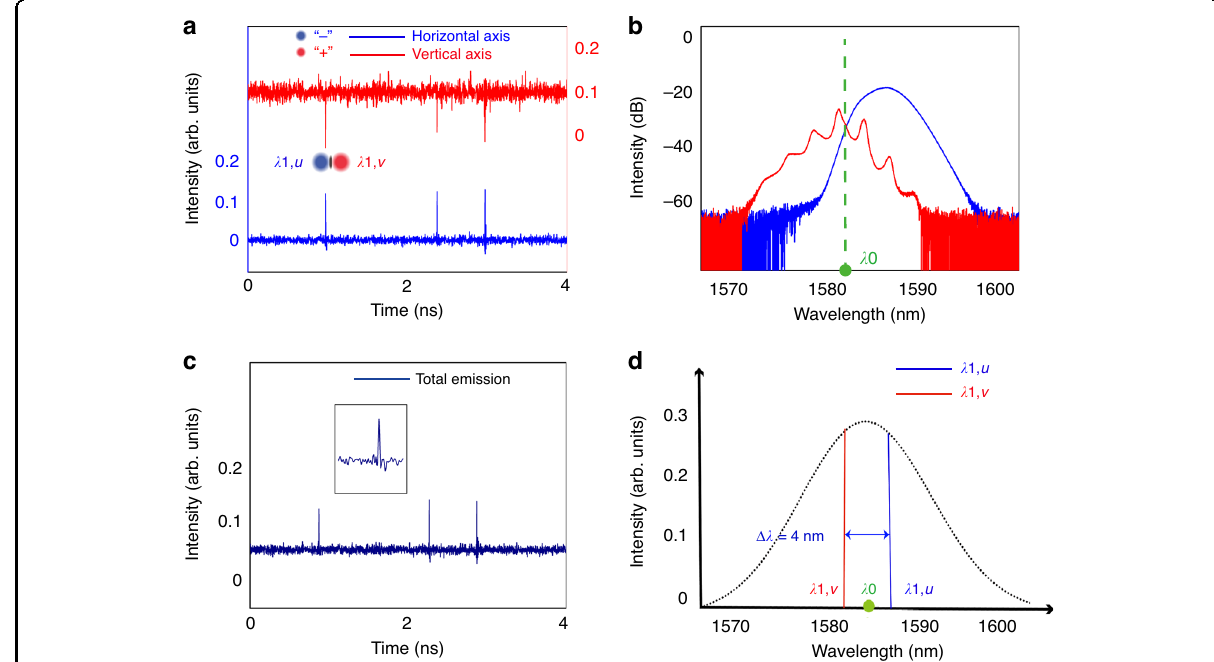
Fig. 4 ODBSs ((1 + 1) PSMs) formed through incoherent cross-polarization coupling. a Polarization-resolved laser emissions. Blue solid line and red solid line: polarization-resolved laser emissions. b Corresponding optical spectrum of ( a ). c Total laser emission of ( a ). Inset: zoom-in of one BS pulse. d Schematic illustration of the soliton wavelengths. λ 0 : central wavelength of the ZGVD point, λ 1, u : central wavelength of the BSs, λ 1, v : central wavelength of the